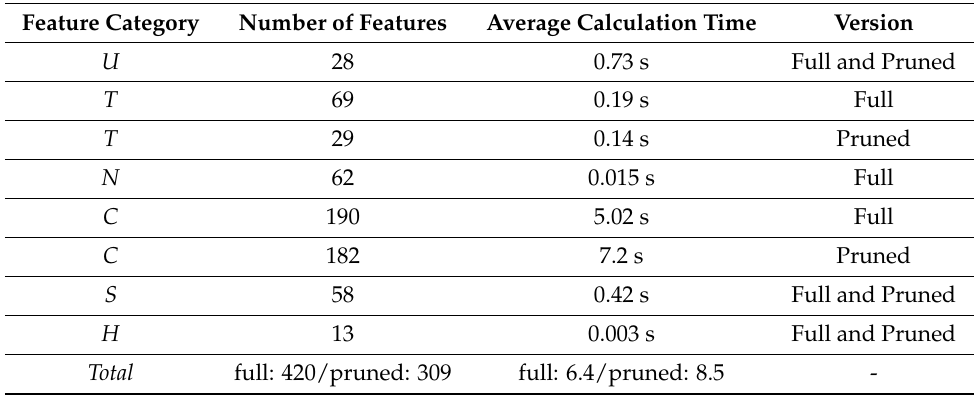
Table 3. Overview of feature characteristics per version. The abbreviations of the first column refer to the features category, see Section 4.1. The social neighborhood feature category (N) is available in the full-features version. The pruned-features version is used for accounts that either have no tweets or no retweets.